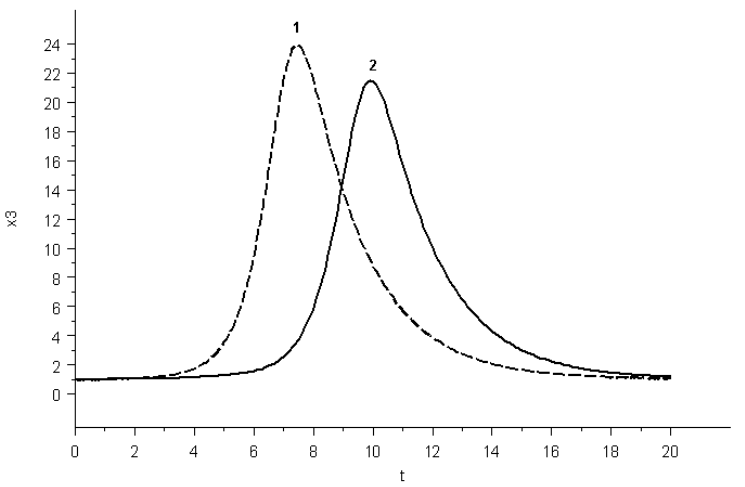
Figure 4. 1—trajectory x 3 for u = 0; 2—computational trajectory x 3 .